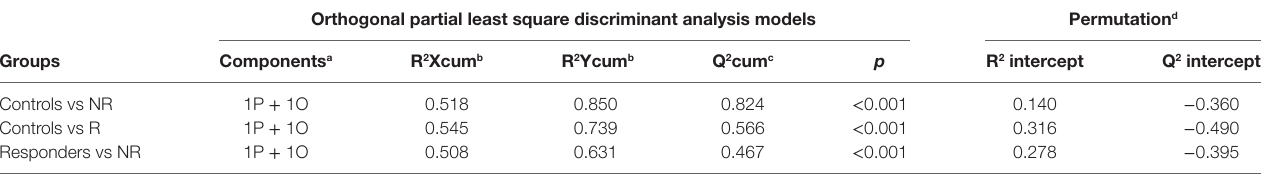
TaBle 3 | Summary of the statistical parameters of the models C vs non-responder (NR), C vs responder (R), and R vs